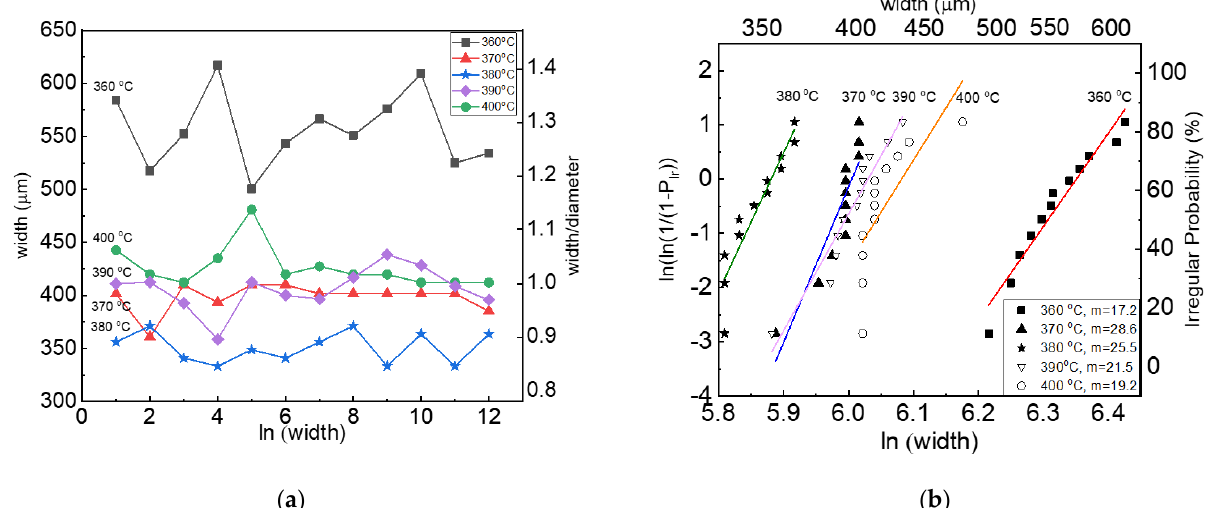
Figure 4. Analysis of printed line reliability used by Weibull modulus: ( a ) Measurement value ratio of line width and nozzle diameter, ( b ) Weibull plot of the line width with various nozzle temperatures.